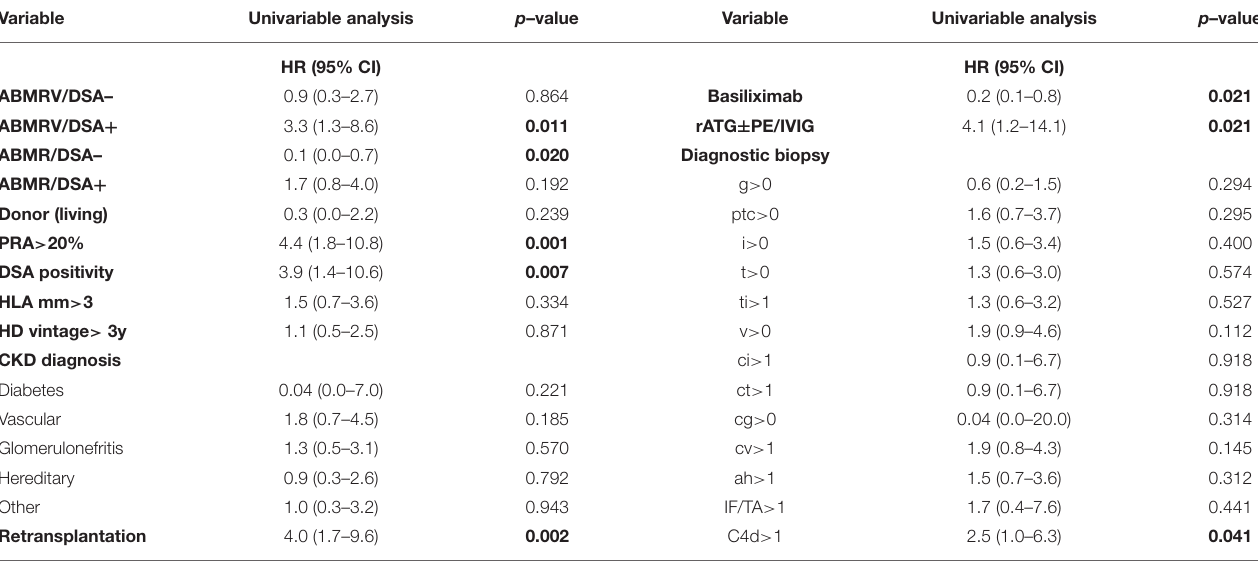
TABLE 5 | Cox regression assessing risk factors of graft failure (No. of events 23) in histologic ABMR rejection categories (ABMR/DSA–, ABMR/DSA + , ABMRV/DSA–, and ABMRV/DSA + ).